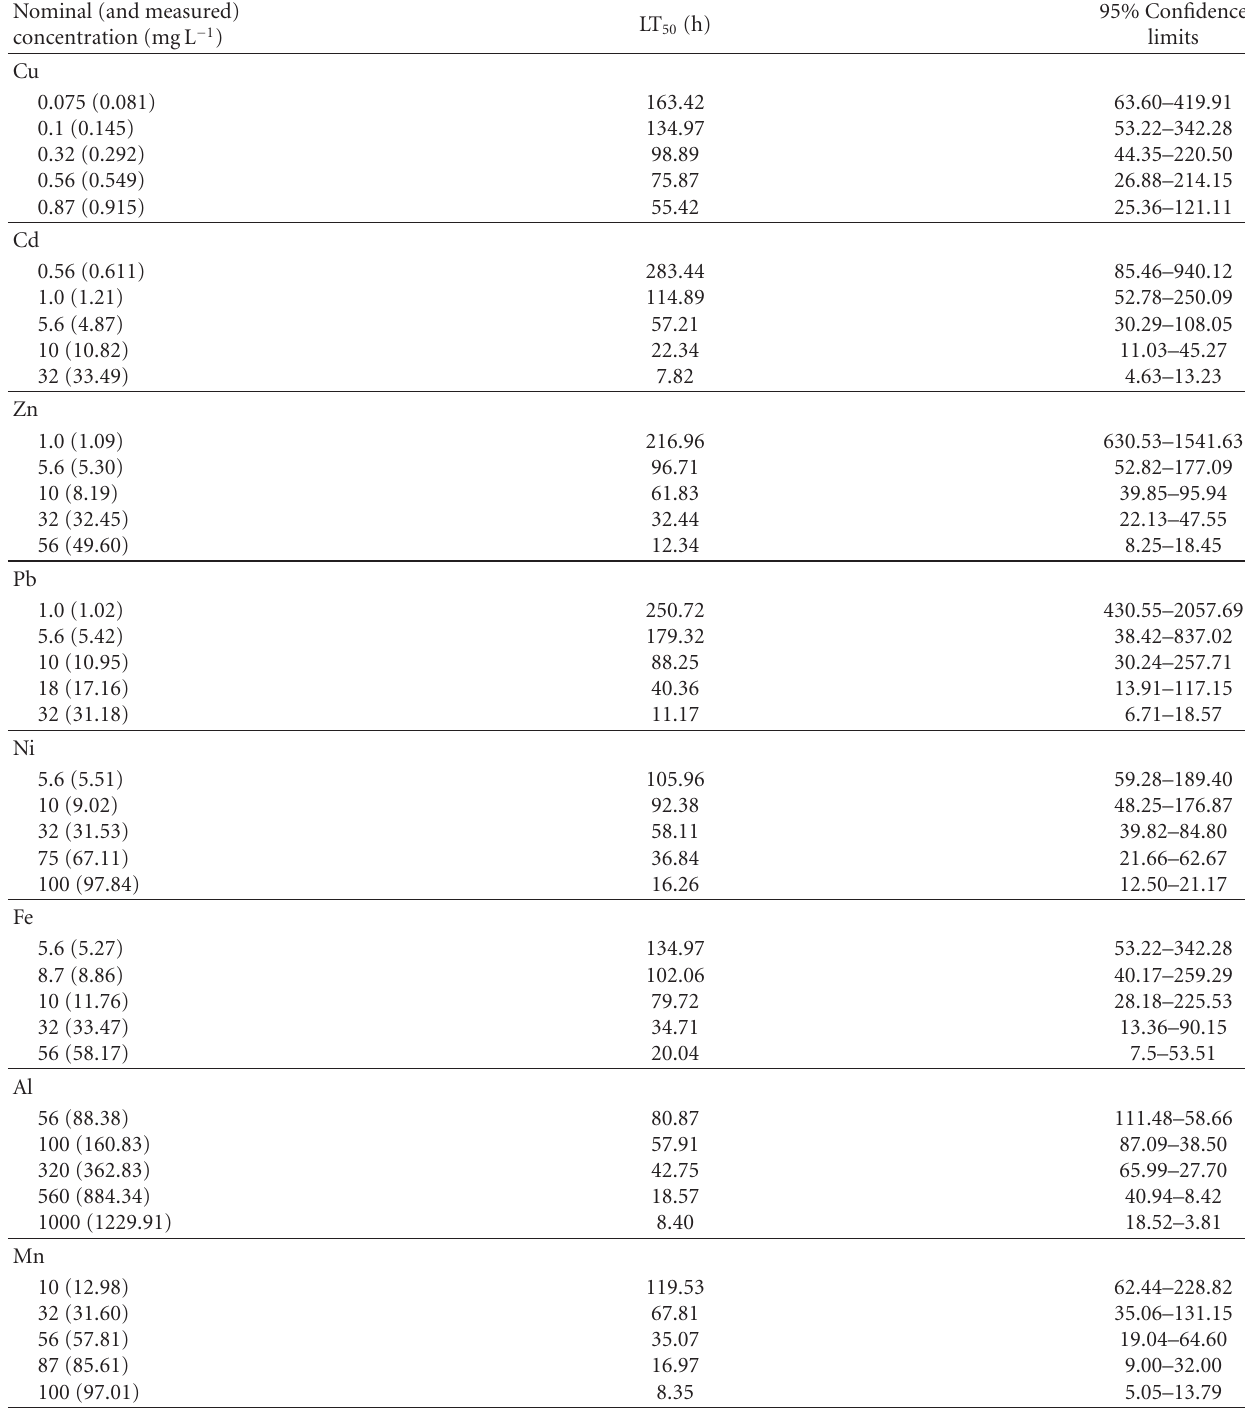
Table 1: Median lethal times (LT 50 ) for M. tuberculata exposed to di ff erent concentrations for Cu, Cd, Zn, Pb, Ni, Fe, Al, and